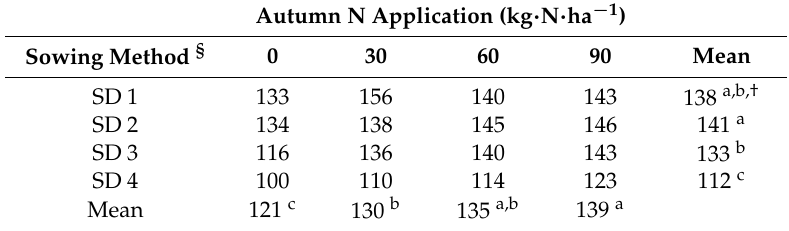
Table 3. Sowing method by autumn N application interaction effects on N offtake by WOSR seed